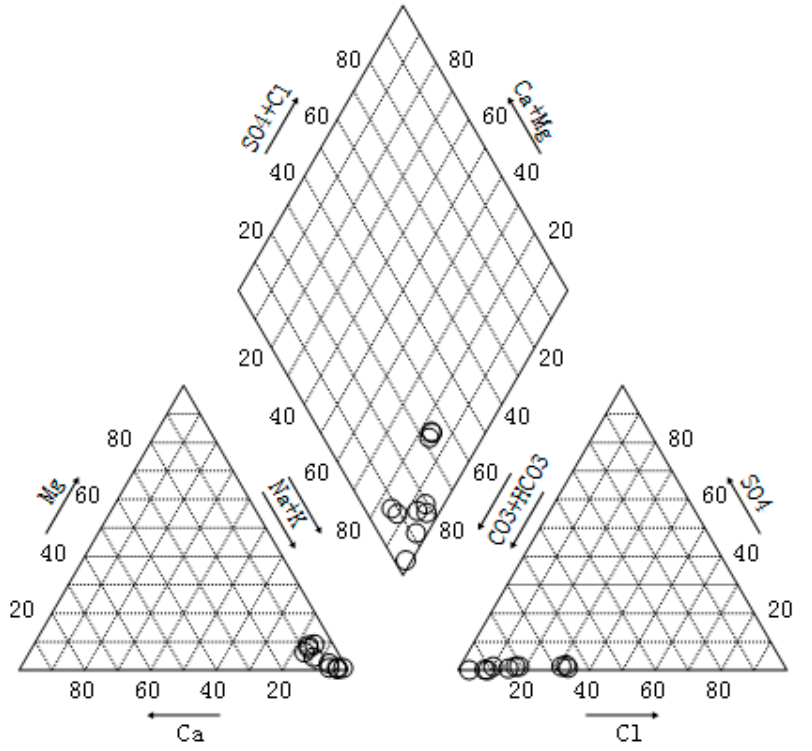
Figure 2. Hydrochemistry type Piper graph of CBM produced water (the eight ion types are Na + , K + , Ca 2+ , Mg 2+ , Cl − , SO 42 − , HCO 3 − , CO 32 − ).